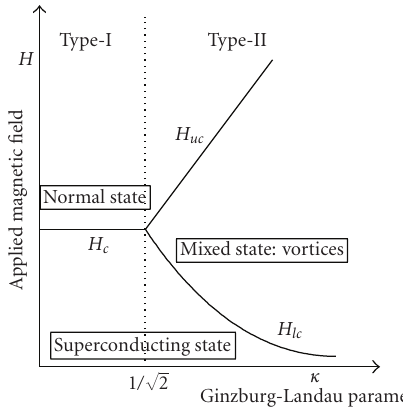
Figure 1.1. The reaction of a superconducting